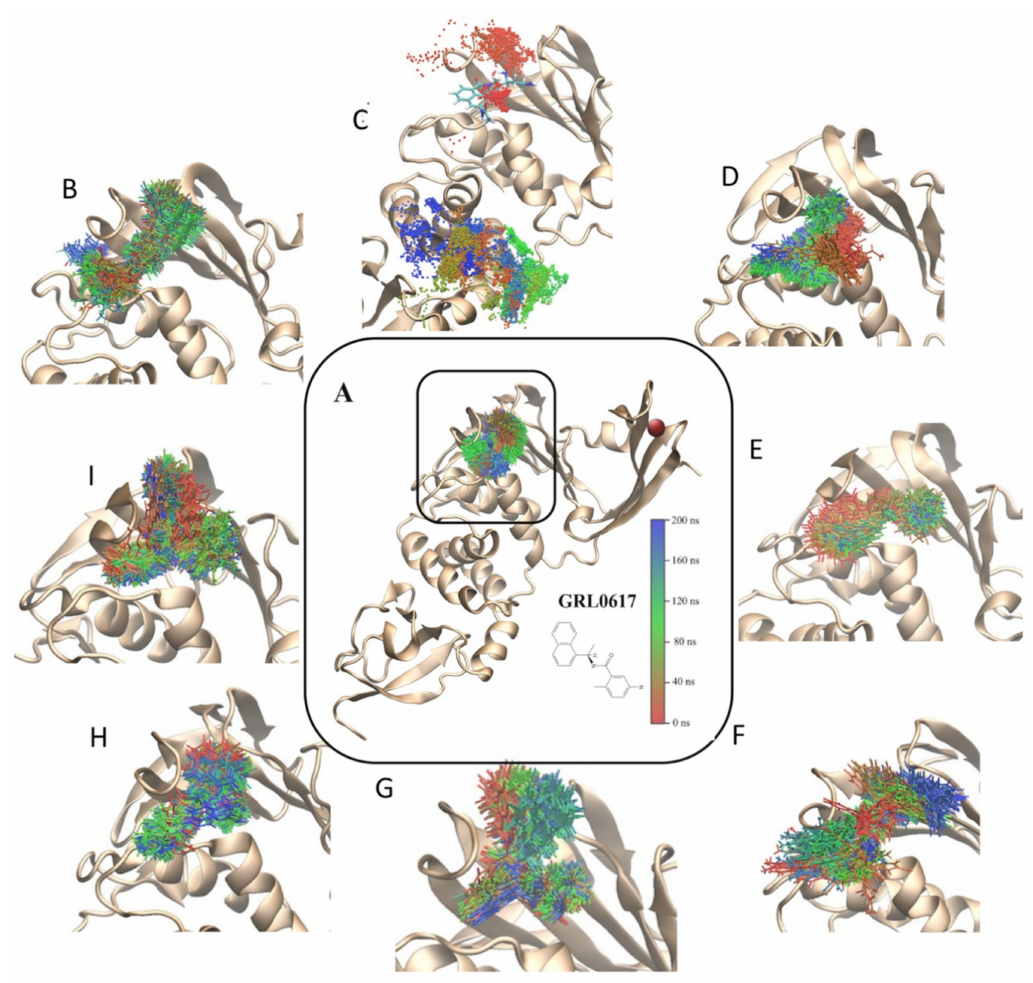
Figure 3. Conformations of the PLpro/ligand complex obtained by MD simulation. Crystallographic models of PLpro inhibitors GRL0617 and 12C ( A and B , respectively) and seven new inhibitor compounds (D24, D28, D04, D59, D60, D99, and D06) obtained by in the in silico search and molecular docking ( C – I ) were used to perform 200 ns MD simulations ( A , B , D – I ). For compounds C12 ( B ), D24 ( C ), D28 ( D ), D04 ( E ), D59 ( F ), D60 ( G ), D99 ( H ), and D06 ( I ), an increase in the binding region of each ligand is observed. The red sphere corresponds to the Zn 2+ ion. The position of the compounds is observed every ns (red 0 ns and blue 200 ns) of the simulation after superimposing the polypeptide chains. For compound D24 ( C ), 400 ns of simulation are observed (red 0 ns and blue 400 ns). The structural formula of each compound is shown in the Supplementary Materials (Figure